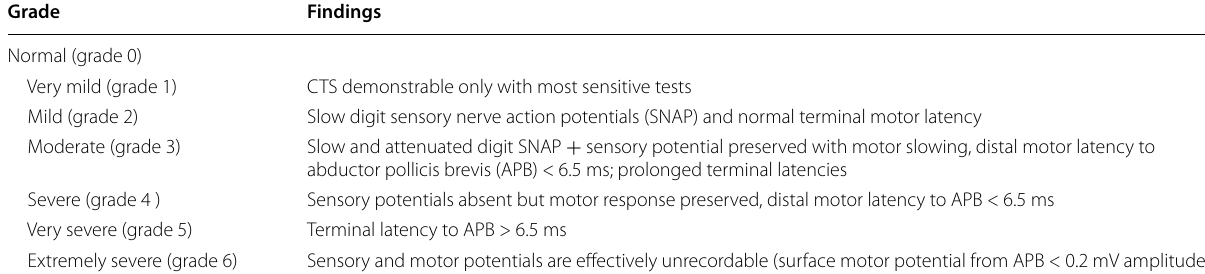
Table 1 Grading of nerve conduction studies for carpal tunnel syndrome (Bland JD [7]) Grade